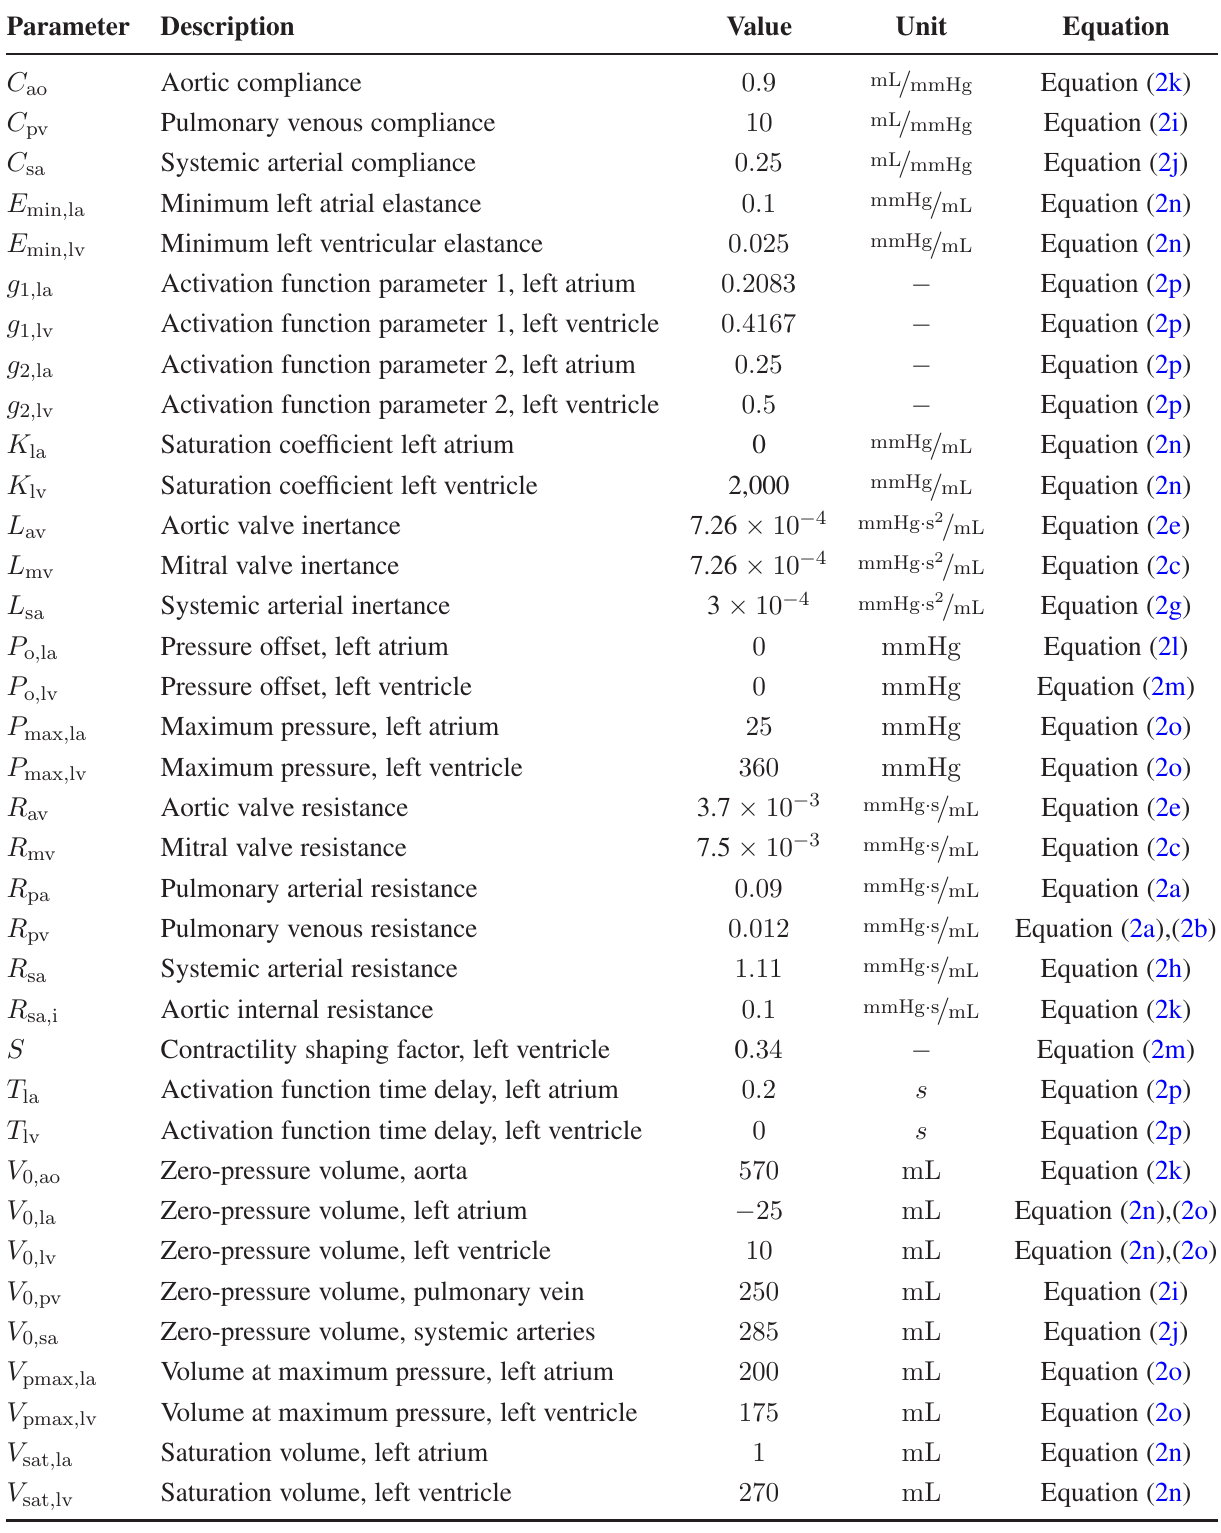
Table A2. Parameters of the reduced circulation